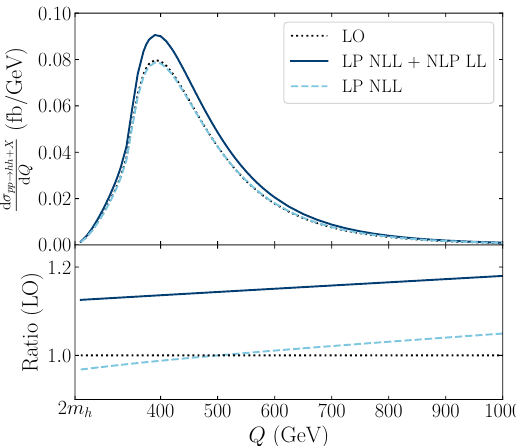
Figure 13. Differential cross section for hh production showing the LO (black dotted), LP NLL (dashed light-blue), and NLP LL + LP NLL (solid dark-blue) results. The scale µ is set to Q/ 2 . The bottom pannel shows the ratio with respect to the LO